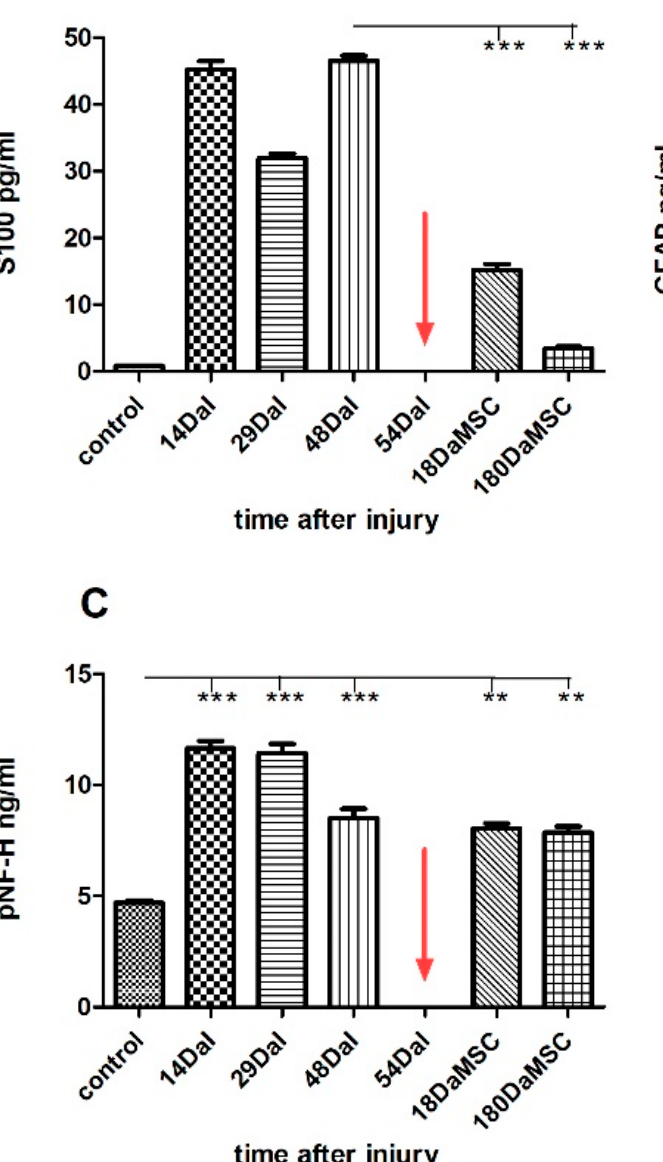
Figure 3. The level of S100 ( A ), GFAP ( B ) , and pNF-H ( C ) protein in the serum of an SCI patient treated with autologous BM-MSCs before and after the treatment. SCI caused a significant increase in S100, GFAP, and pNF-H protein levels in the patient’s serum in comparison with healthy controls ( A – C ). Administration of autologous BM-MSCs to the patient at day 54 post-injury resulted in